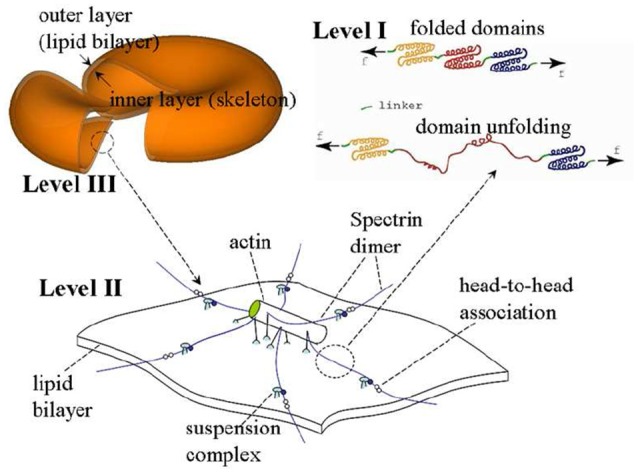
A sketch of the multiscale RBC model.